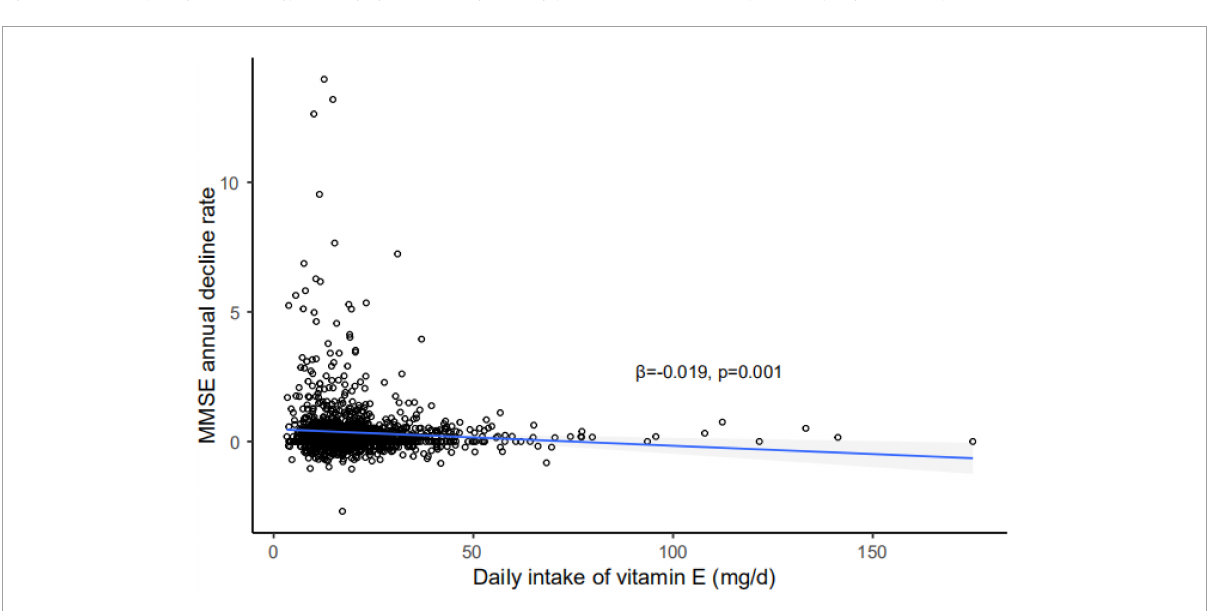
FIGURE2 Correlation of annual MMSE decline rate with daily intake of vitamin E. Vitamin E intake was negatively related to the rate of annual decline of MMSE, after adjusted for age, gender, smoking, drinking, years of education, APOE, physical activity, cognitive activity, BMI, CESD, and total energy intake. Shadow represents 95% confidence interval (CI); solid line represents regression line; MMSE, Mini-Mental State Examination; APOE, apolipoprotein